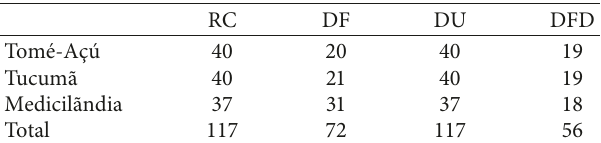
Table 1: Spectra collected by region and category: raw cocoa (RC), dried unfermented cocoa (DU), dried fermented cocoa (DF), and dried fermented degreased